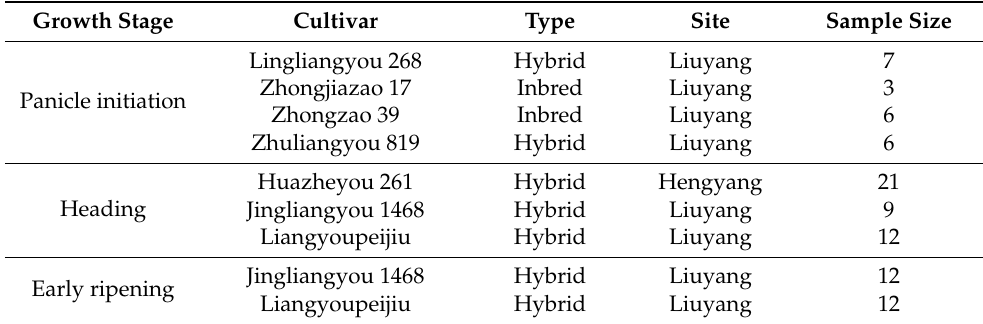
Table 1. Descriptions of leaf